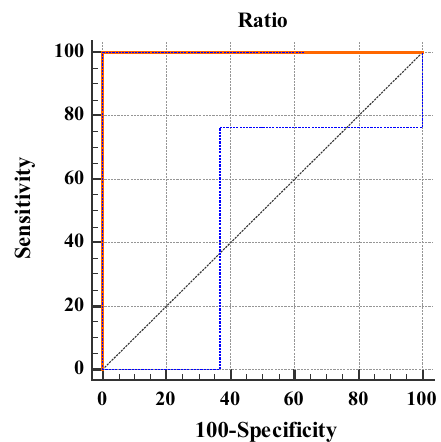
Fig. 7 ROC curve for the diagnostic performance of ADC ratio